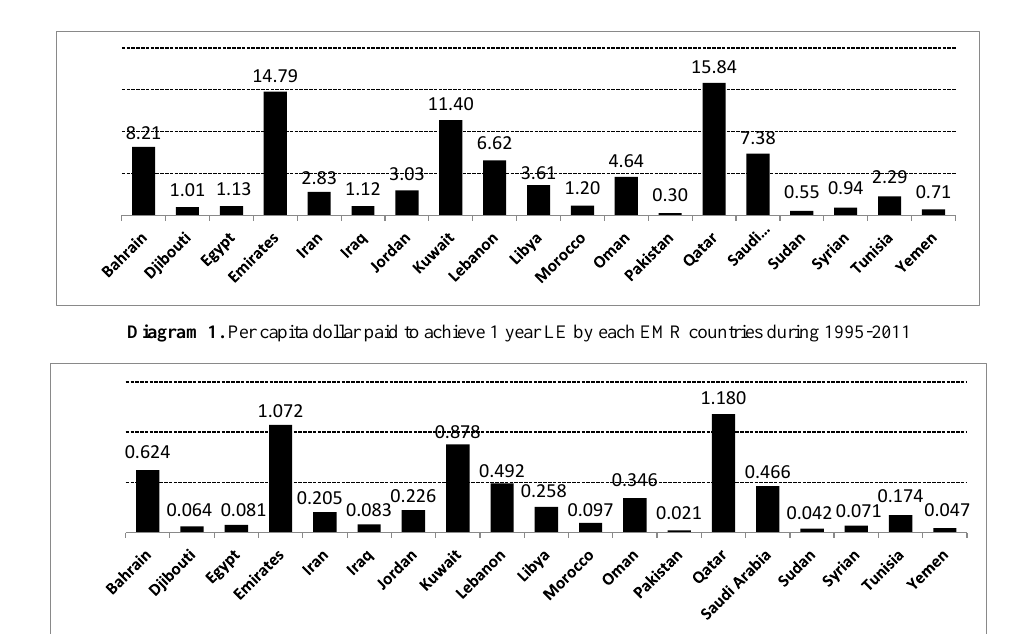
Table 2, countries with better public health status